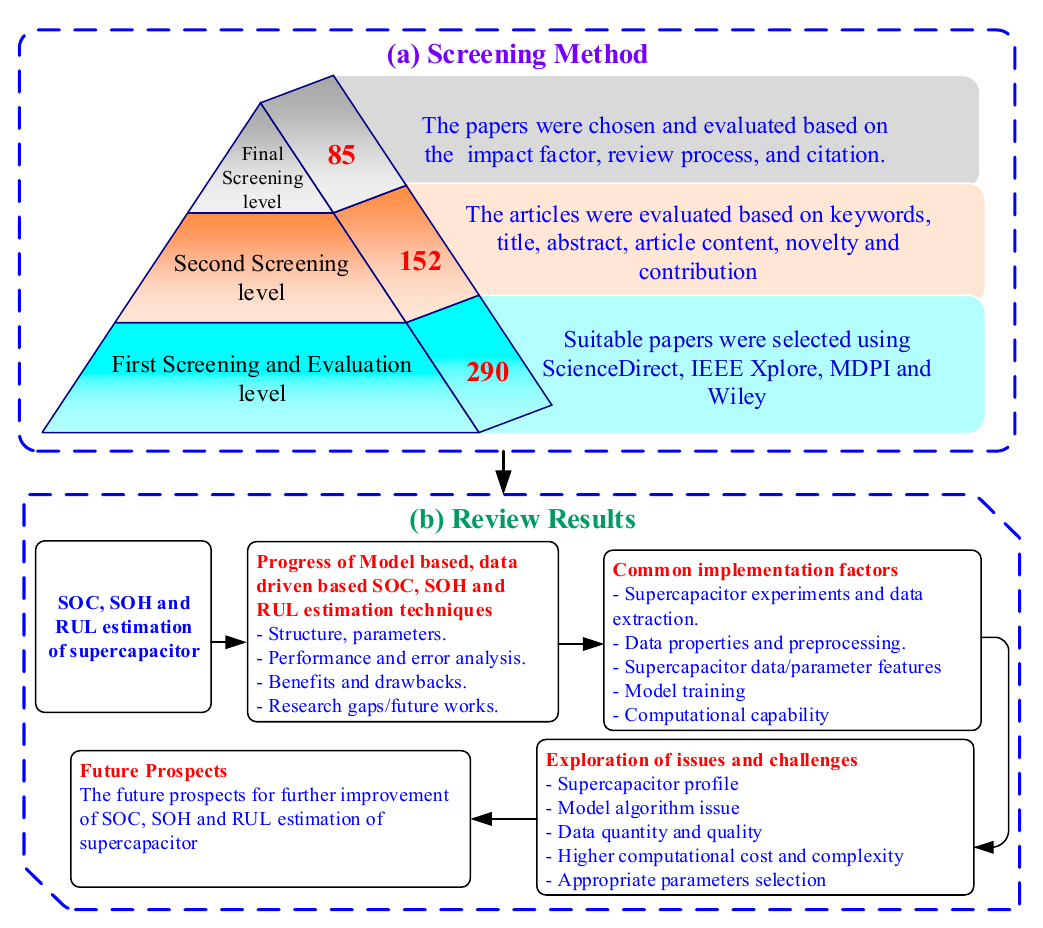
Figure 2. Schematic process of the a) screening method, b) review results for the presented review.